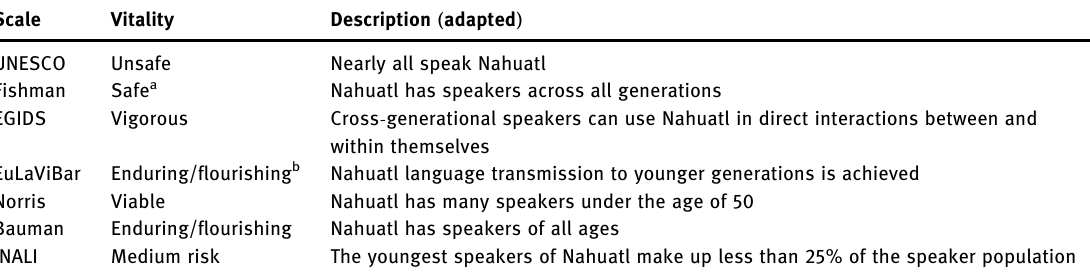
Table 5: Nahuatl language vitality in Tlaxco ( by absolute speaker population )